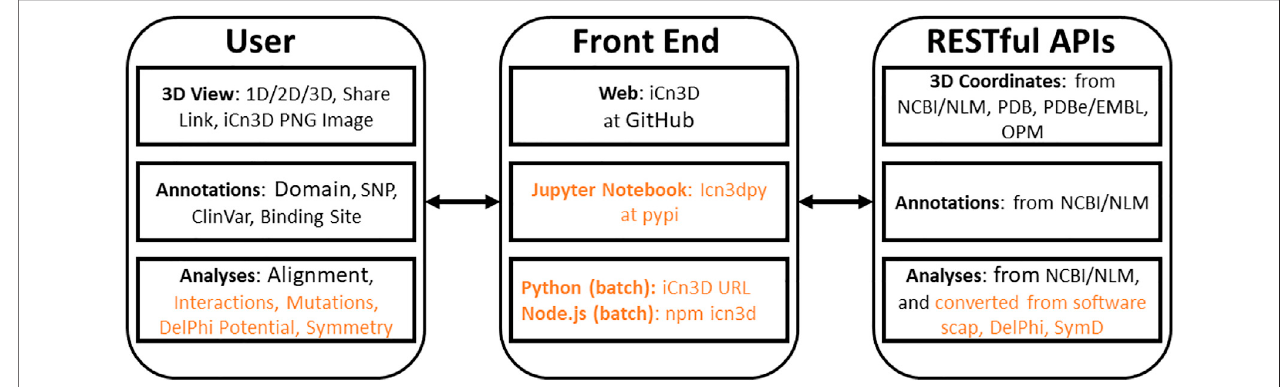
FIGURE 1 | Front end and backend of iCn3D. The new additions are colored in